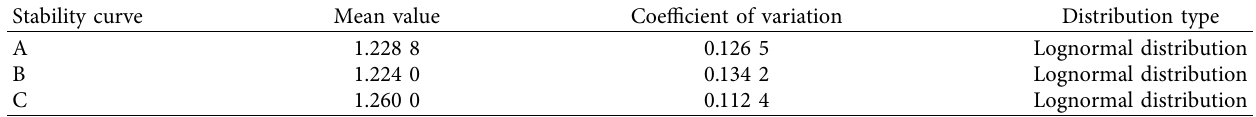
Table 6: Resistance variation in strength curves.